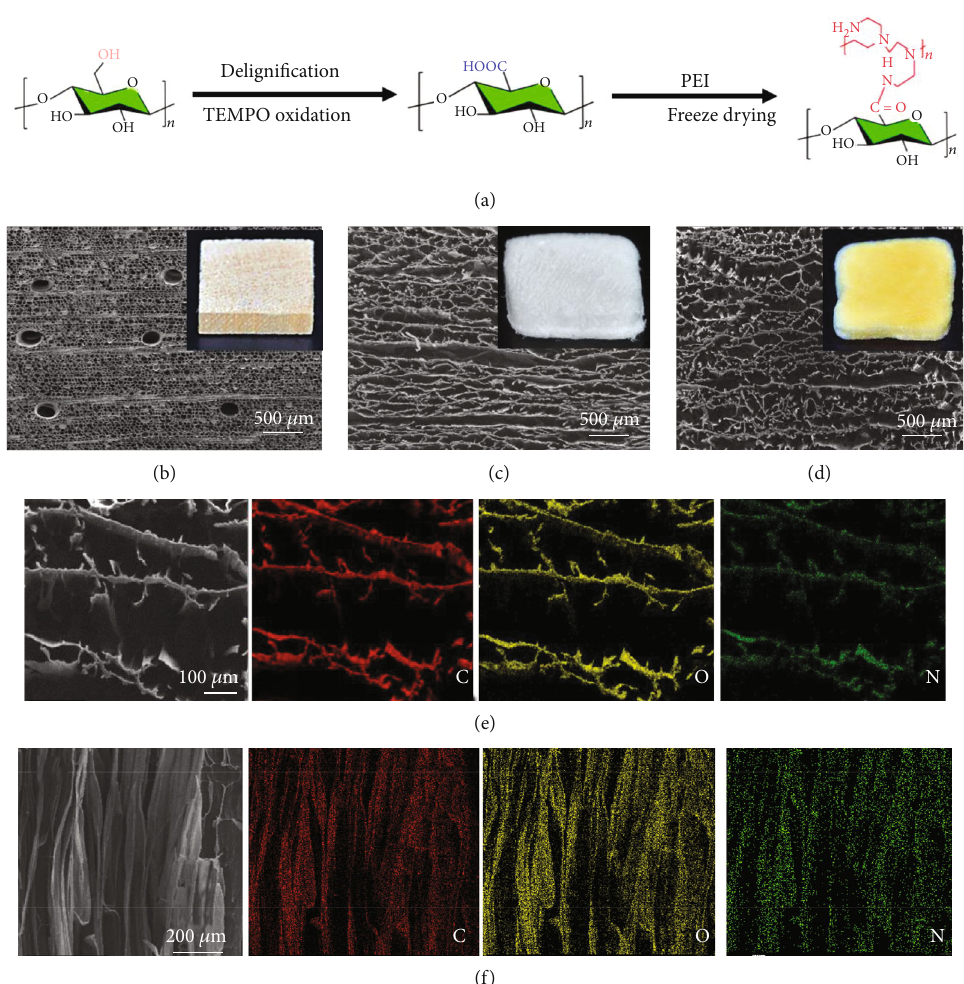
Figure 1: (a) Preparation process of the PEI@wood aerogel; (b – d) SEM images of the natural wood, TEMPO-oxidized wood aerogel, and PEI@wood aerogel; (e and f) EDX mapping images of the cross and radial sections of PEI@wood Table 1: Apparent density, porosity, and speci fi c surface area of natural wood, TEMPO-oxidized wood aerogel, and PEI@wood aerogel. Sample Natural wood